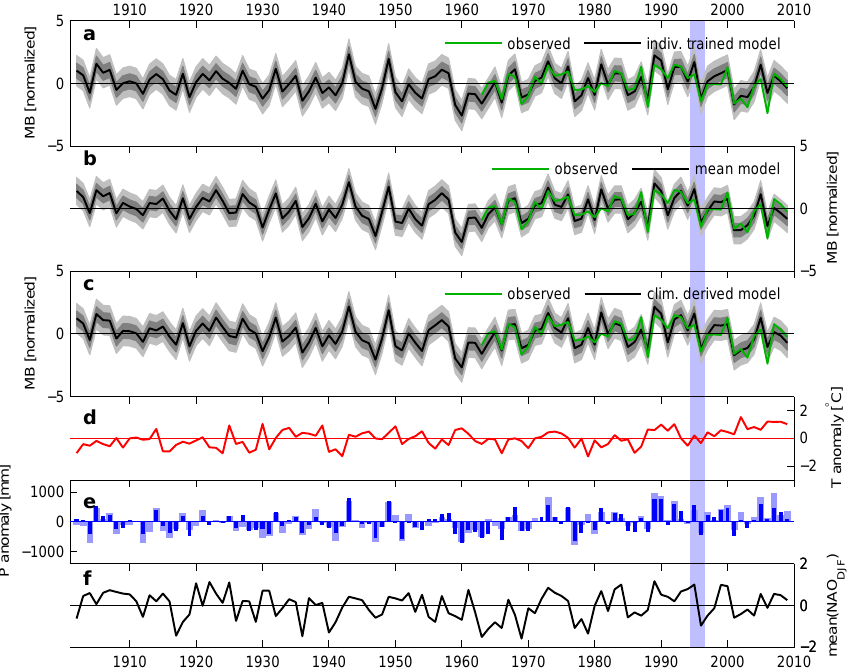
Fig. 6. Timeseries of the reconstruction for ˚Alfotbreen. (a) green: standardized MB measured , black: standardized MB model , light gray shading: ± 2 · rmse, dark gray shading: ± 1 · rmse. (b) green: standardized MB ± 2 · measured , black: standardized MB mean model , light gray shading: rmse, dark gray shading: ± 1 · rmse. (c) green: standardized MB measured , black: standardized MB clim model , light gray shading: ± 2 · rmse, dark gray shading: ± 1 · rmse. (d) annual temperature anomaly at the location of the glacier. (e) annual precipitation anomaly at the location of the glacier, light blue: total precipitation, dark blue: estimated solid precipitation. (f) winter mean of the NAO index. The vertical light blue bar indicates the two years shown in detail in Fig. 7. Equivalent figures are available for all 39 glaciers with more than 12 measured mass balance values as Supplement.